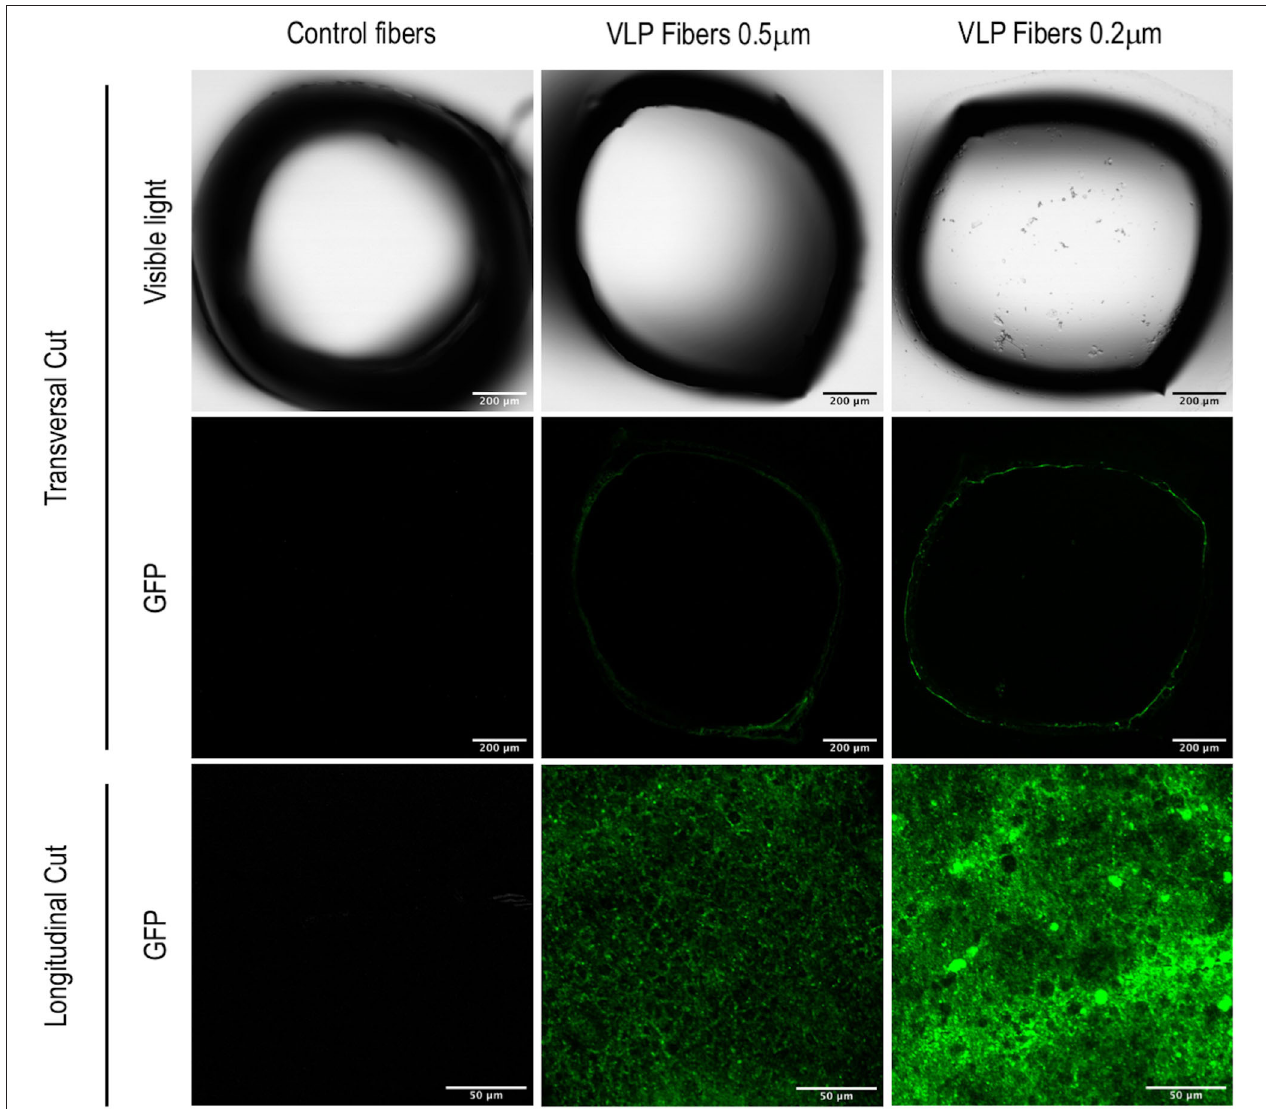
FIGURE 6 | Visualization of ATF hollow fibers using confocal microscopy. Columns represent the different studied conditions: control fibers used in non-producing-VLPs HEK293 cultures and fibers used in VLP-producing HEK293 cultures of 0.5 and 0.2 µ m of pore diameter. The first row shows transversal cuts of the fibers under visible light. The second row shows GFP fluorescence of the same transversal cut. The third row shows GFP fluorescence from a longitudinal cut of the luminal